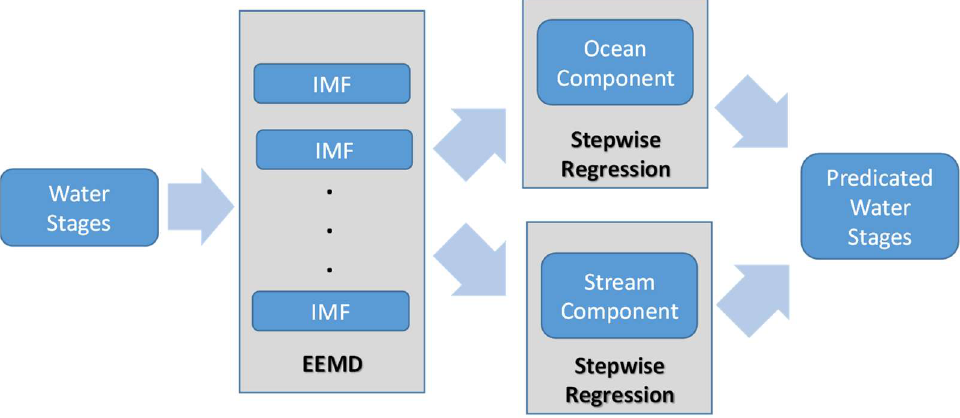
Figure 1. The approach used for forecasting water level in a tidal river.